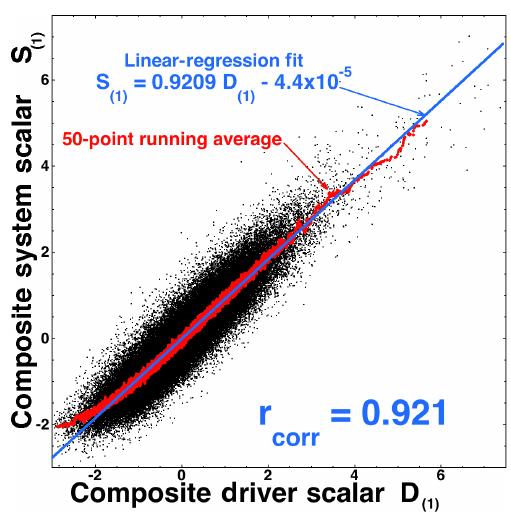
Figure 1. The aggregate system scalar S ( 1 ) is plotted as a function of the driver scalar D ( 1 ) for the 1h resolution 1991–2007 data set. Each black point is 1h of